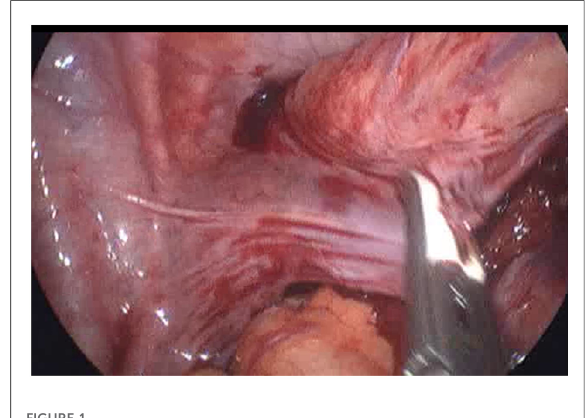
FIGURE 1 Devascularization of the distal